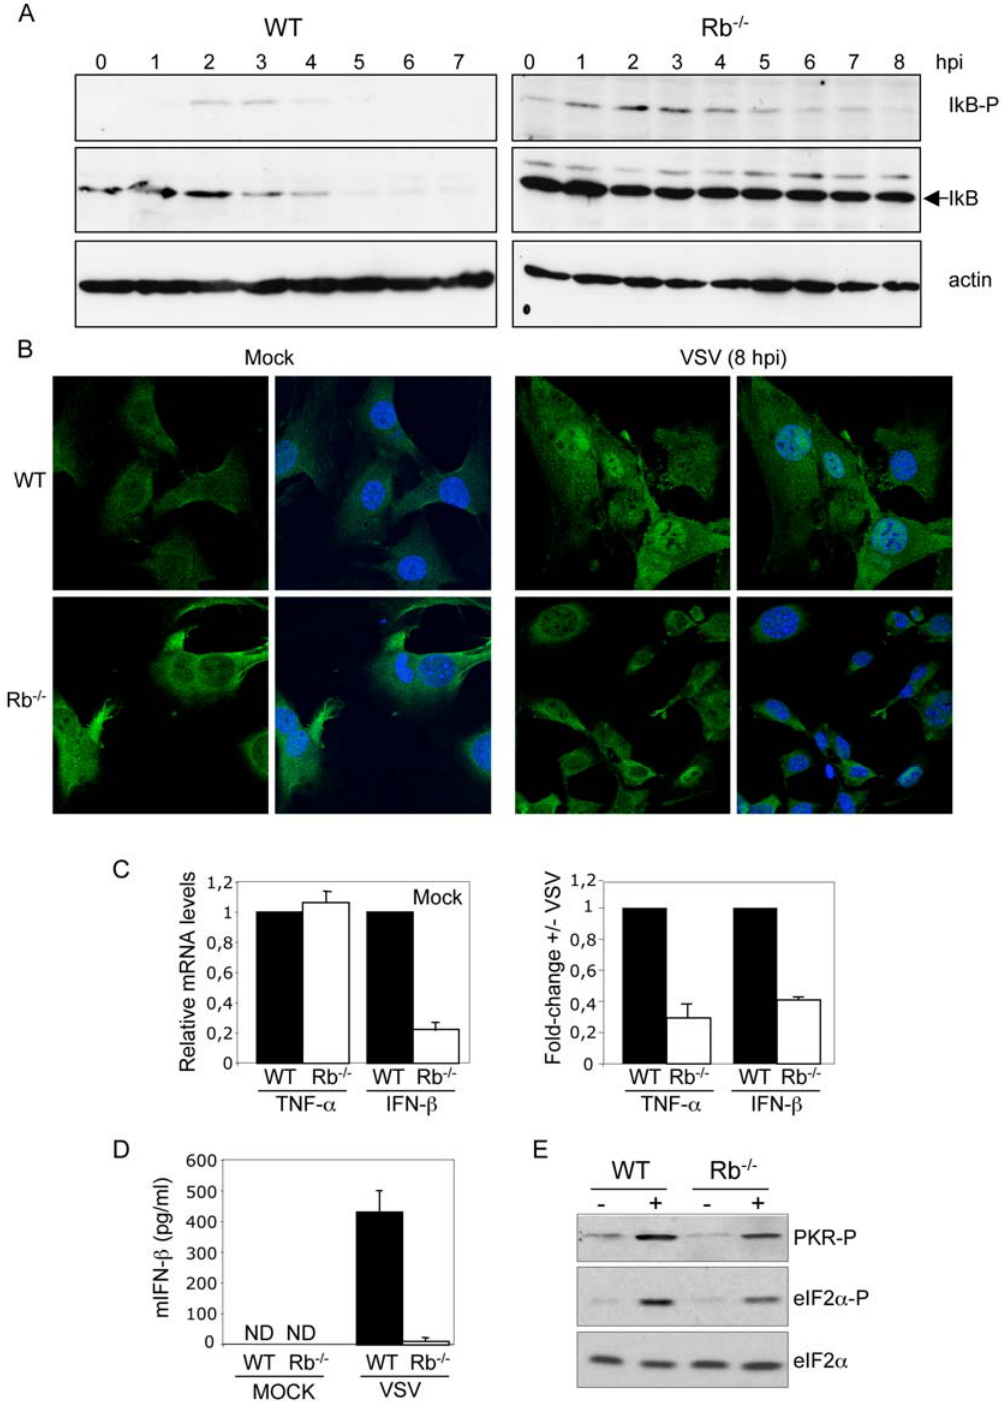
Figure 2. Rb expression is required for NF-kB pathway activation in response to VSV infection. A, Kinetics of IkB a phosphorylation on serine 32 and serine 36 and total IkB upon VSV infection at M.O.I. of 5 PFU/cell in wild type (left panel) or Rb 2 / 2 (right panel) primary MEFs were assessed by Western-blotting analysis. B, Wild type or Rb 2 / 2 MEFs were infected with VSV at M.O.I. of 5 and 8 h after infection cells were fixed, immunostained for p65 (green) and DAPI (blue). C, Wild type or Rb 2 / 2 MEFs were infected with VSV at M.O.I. of 5 and 12 h after infection total RNA was isolated. After reverse transcription the samples were amplified by TaqMan-based QRT-PCR using taqman probes for TNF- a , IFN- b , and GADPDH, and analyzed. The expression levels were determined relative to GAPDH and represented as fold change in Rb 2 / 2 cells relative to the expression detected in WT cells. All errors bars indicate mean + / 2 SE. D, MEFs were infected with VSV at M.O.I. of 5 and 24 h after infection IFN- b production in the cell culture supernatants was measured by ELISA. All errors bars indicate mean + / 2 SE. ND, not detected. E, Rb 2 / 2 or WT MEFs were infected with VSV at M.O.I. of 5 and 7 h after infection, Western-blotting analysis using the indicated antibodies was performed.